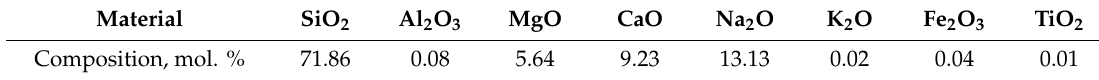
Table 3. Chemical composition of the soda lime glass [23].